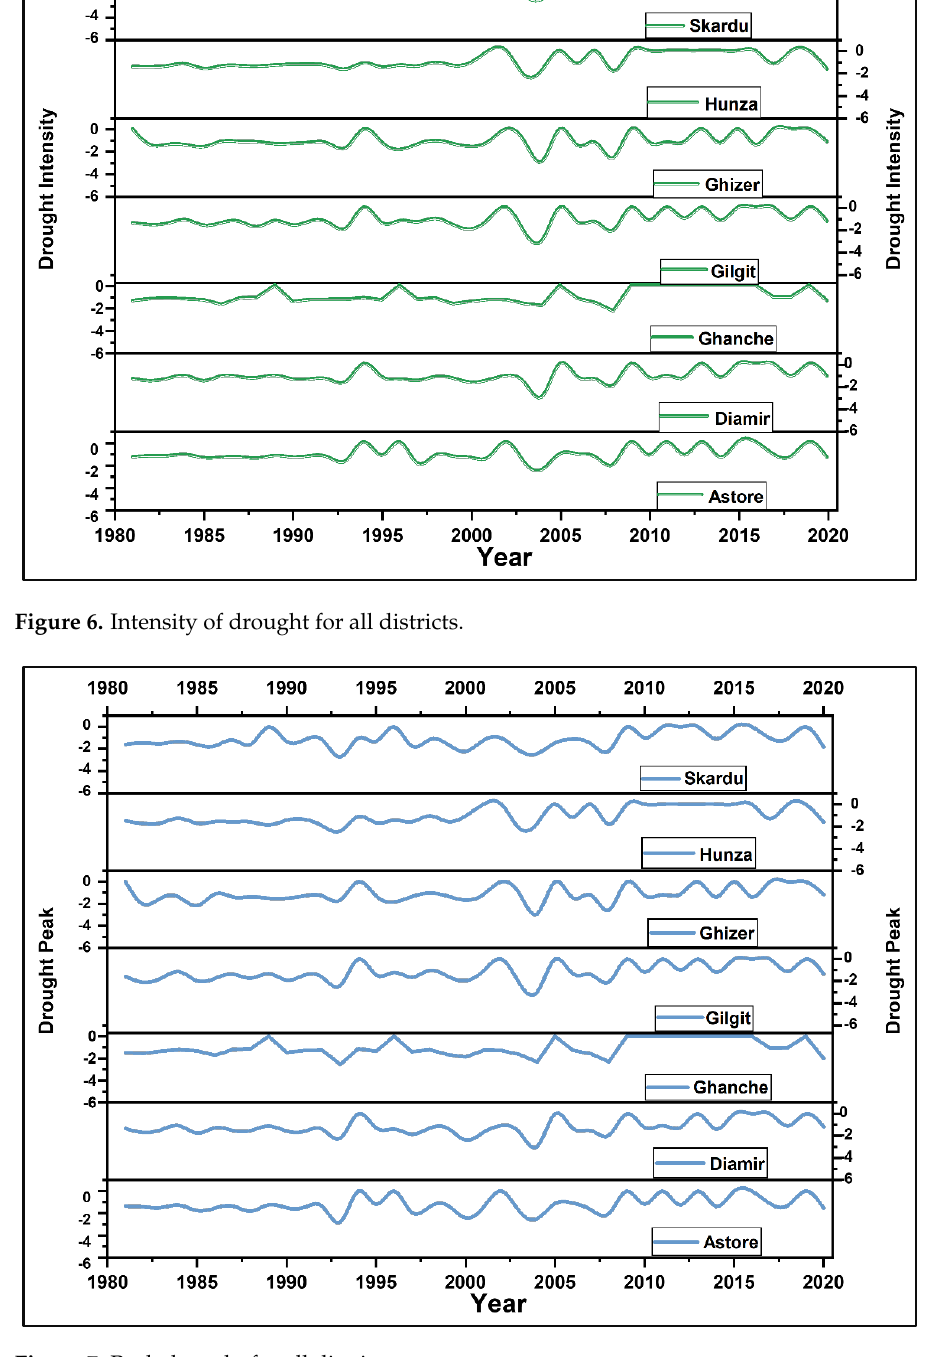
Figure 7. Peak drought for all districts.